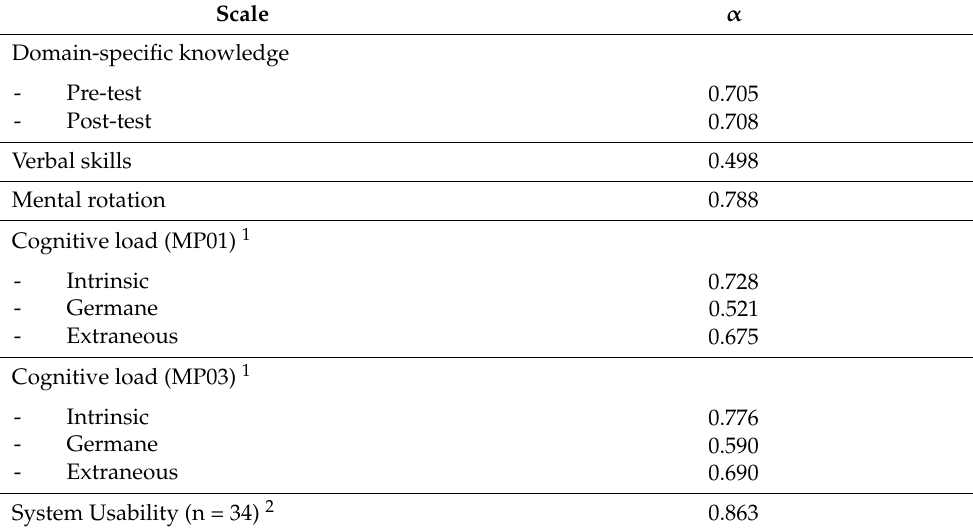
Table 1. Internal consistency of the relevant